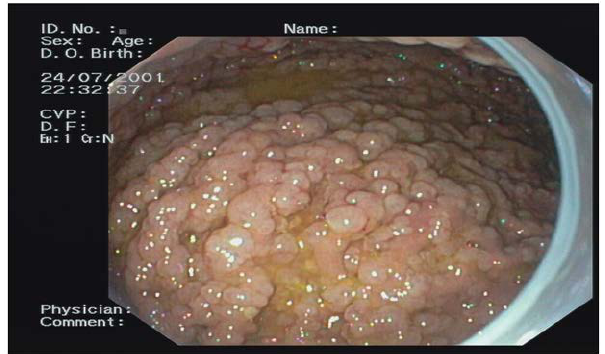
Figure 5 . Diffuse fundic gland polyps.